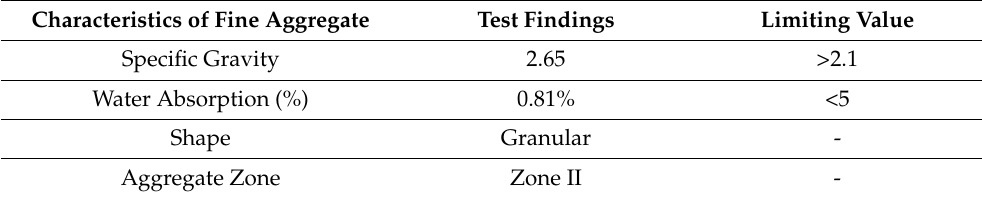
Table 3. Physical Characteristics of Fine Aggregate.